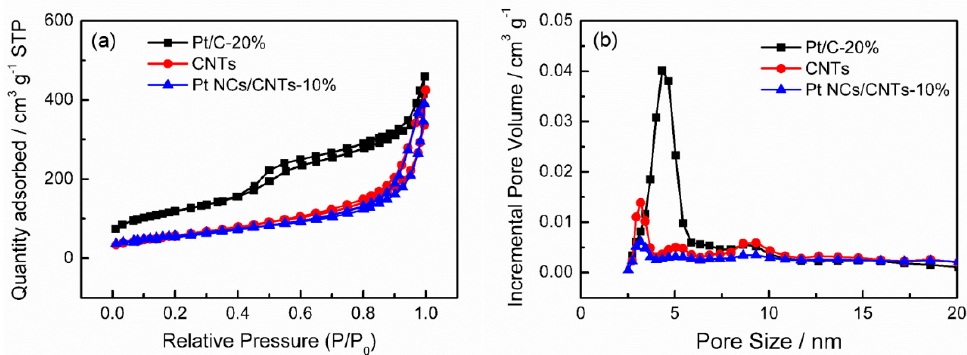
Figure 3. ( a ) N 2 adsorption/desorption isotherms and ( b ) pore size distributions of CNTs, Pt NCs/CNTs-10%, and Pt/C-20%.